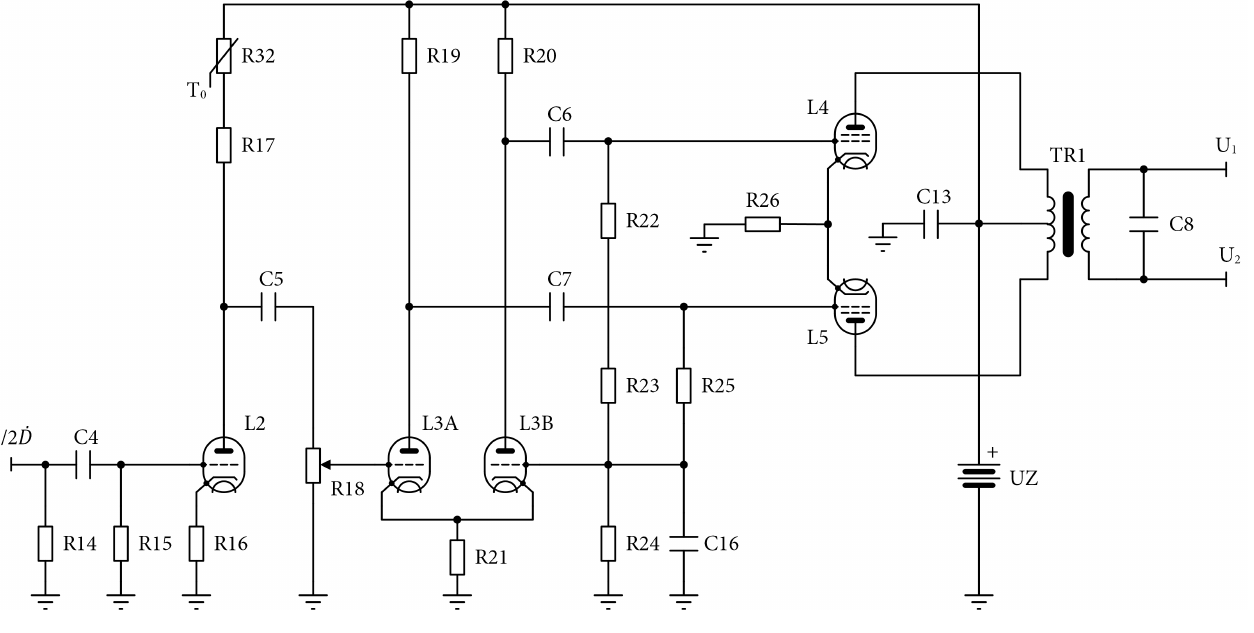
Figure 1. Diagram of the LF tube amplifier.